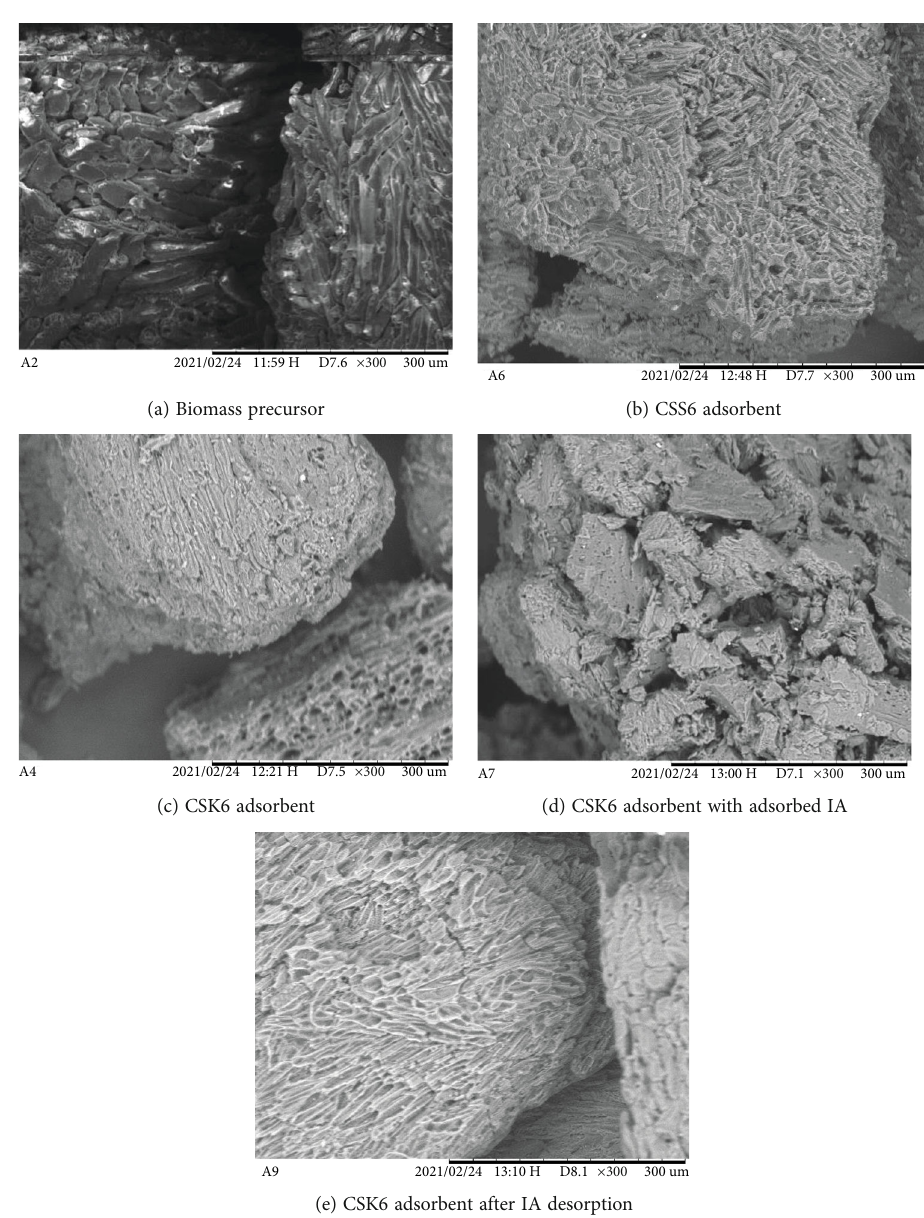
Figure 3: SEM images of biomass precursor and adsorbents prepared and applied in itaconic acid separation from the aqueous